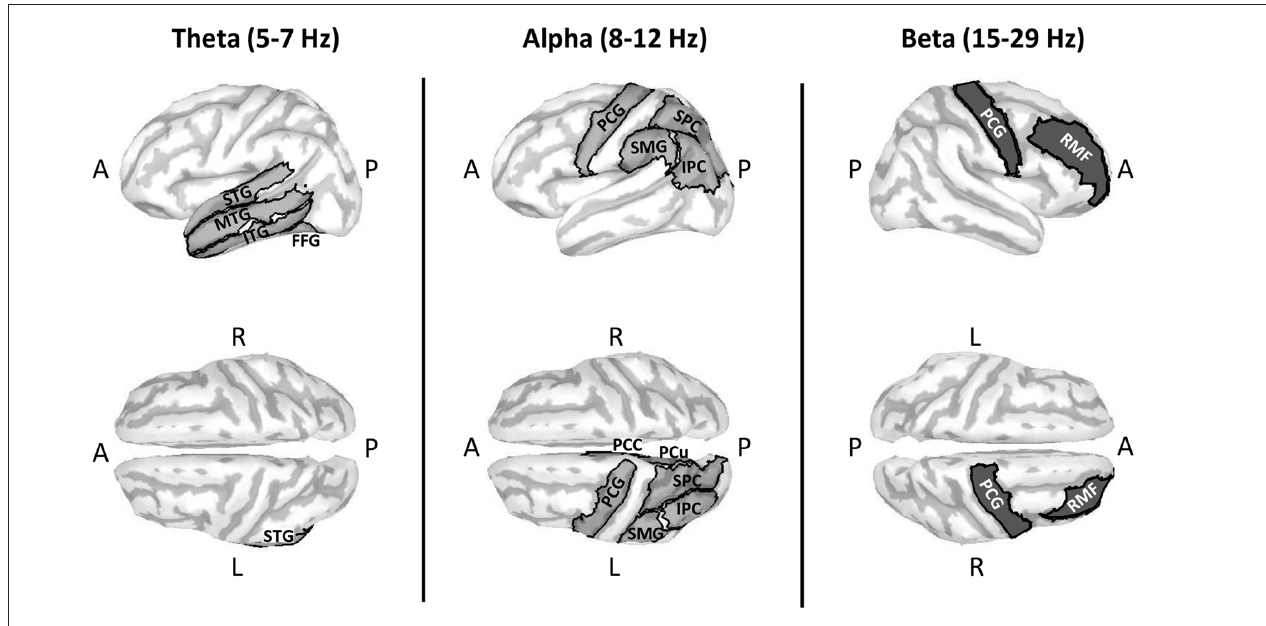
FIGURE 3 | Cortical maps highlighting areas with significantly different oscillatory activity between conditions for the Multi-finger task. Compared to Copy, Improvise induced mean current density strengths over the mental imagery period that were higher in the theta band in the left temporal cortex, higher in the alpha band primarily in the left posterior parietal cortex and lower in the beta band in right prefrontal areas. Improvisational cognition was thus differentiated according to the frequency of oscillatory activity in non-overlapping brain regions. A, P, L and R, respectively denote anterior, posterior, left and right. For further details, see Table 1